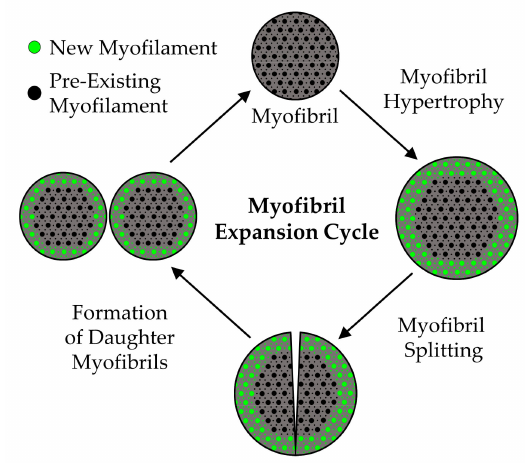
Figure 11. Illustration of the proposed “Myofibril Expansion